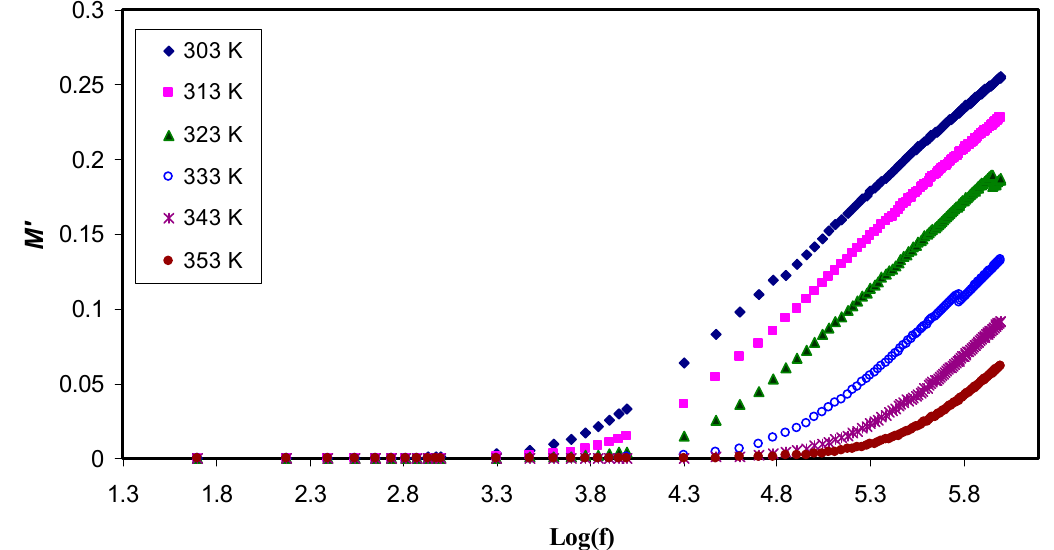
Figure 8. Realpart of the electric modulus ( M ′ ) as a function of the logarithm of frequency ( f ) at different temperatures. It is obvious that M ′ decreases with increasing temperature at high frequency region while it has a low value at the low frequency region due to the suppression of the electrode polarization effect.